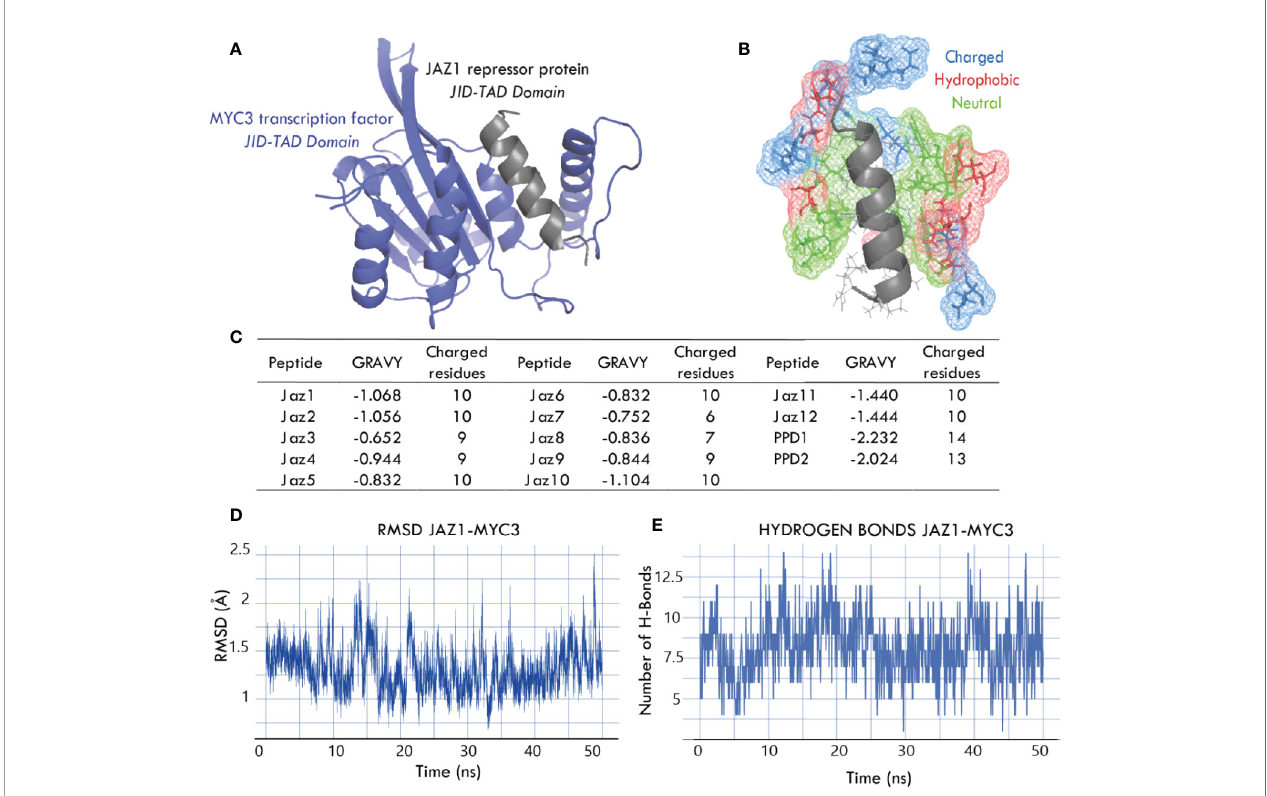
FIGURE 3 | (A, B) Interaction domains between JAZ1 (Jas) and MYC3 (JID-TAD) proteins reveal a hydrophobic and charged pocket that surrounds the Jas degron; this coupling mechanism is similar in all 14 models. Charged, hydrophobic, and neutral amino acids are depicted in blue, red, and green, respectively. (C) The table shows the biochemical properties of Jas and Jas-like domains, GRAVY scores below 0 indicate that the binding interface in all JAZ/PPD-MYC3 complexes is highly hydrophobic. The number of charged residues within the domain indicates that the electrostatic interactions predominate in the interface. (D) The RMSD plot of JAZ1-MYC3 complex during the 50-ns molecular dynamics simulation indicates that the simulations reached the equilibrium. This behavior is observed for all 14 simulations. (E) Fluctuation of the number of hydrogen bonds of that JAZ1-MYC3 interface during the 50-ns molecular dynamics simulation shows that the H-bond network is stable, and that there is no uncoupling of the